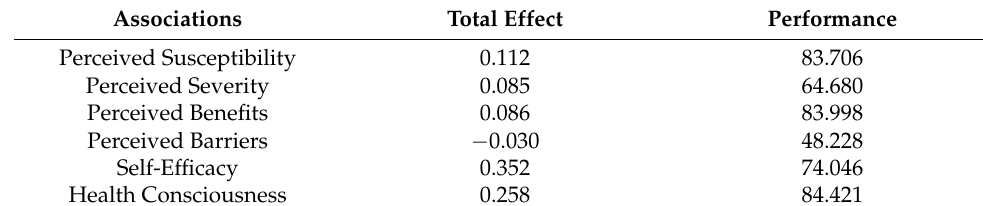
Table 7. Data of the importance performance map for healthy dietary behaviors.